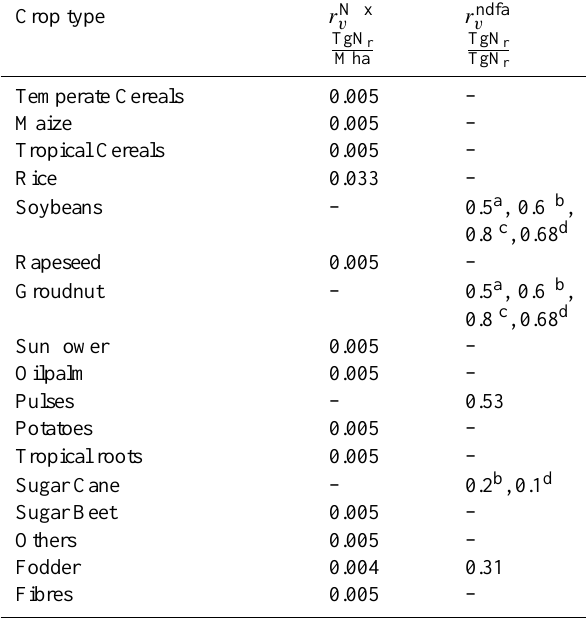
Table A6. Estimates of N r fixation rates per area ( r Nfix v ) or as per- centage of plant N r ( r ndfa v ), based on Herridge et al. (2008) and aggregated to MAgPIE crop